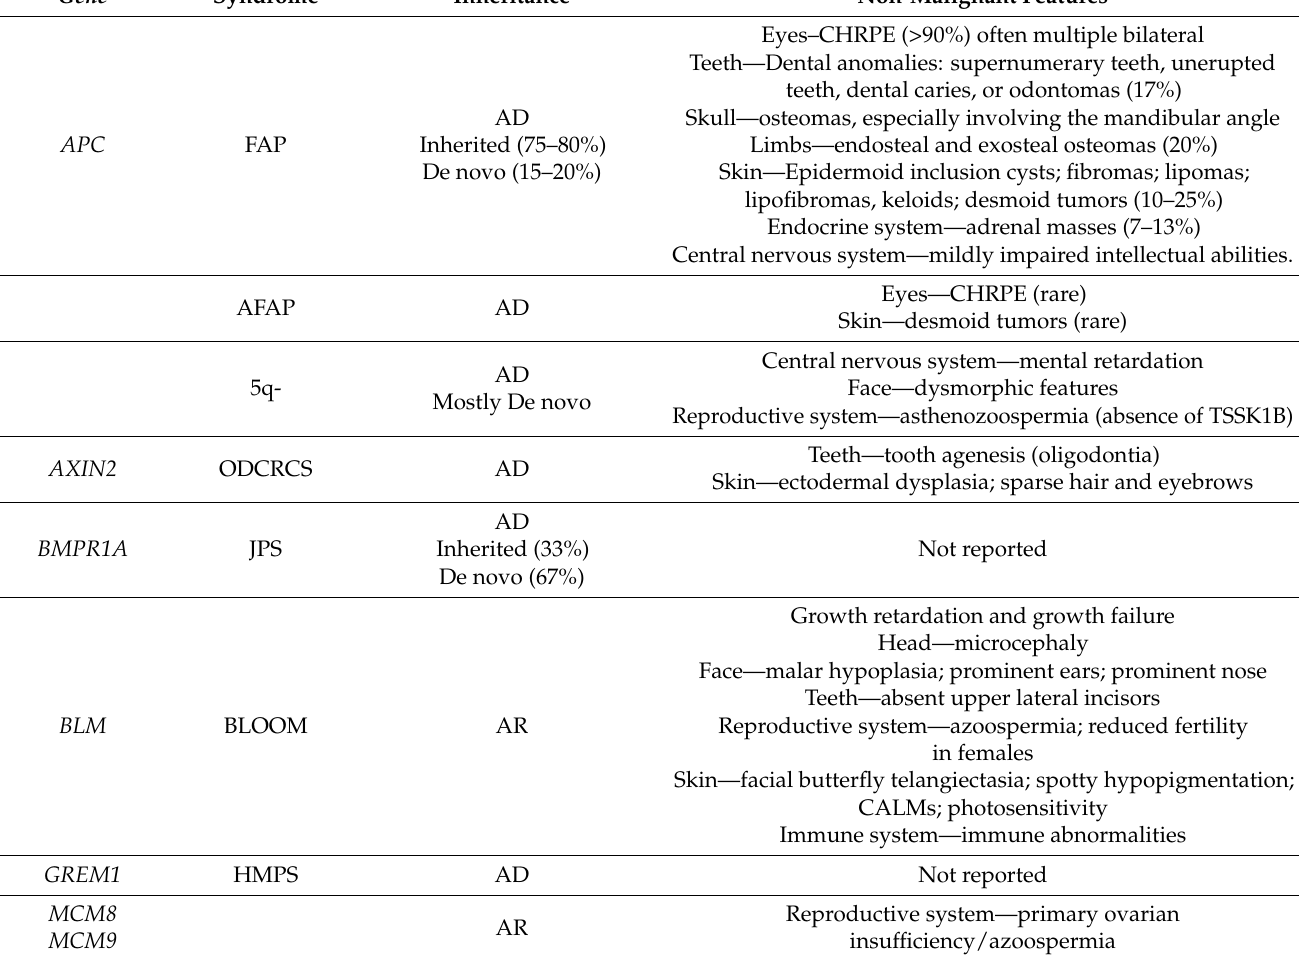
Table 2. Inherited colorectal cancer predisposition syndromes and major non-malignant